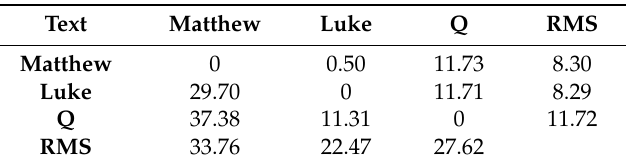
Table 13. Double Tradition and Q. Kolmogorov–Smirnov test results for I P (below the diagonal of zeros) and M F (above the diagonal). The values reported are the confidence level (%) that the indicated couple of probability distributions are not identical.